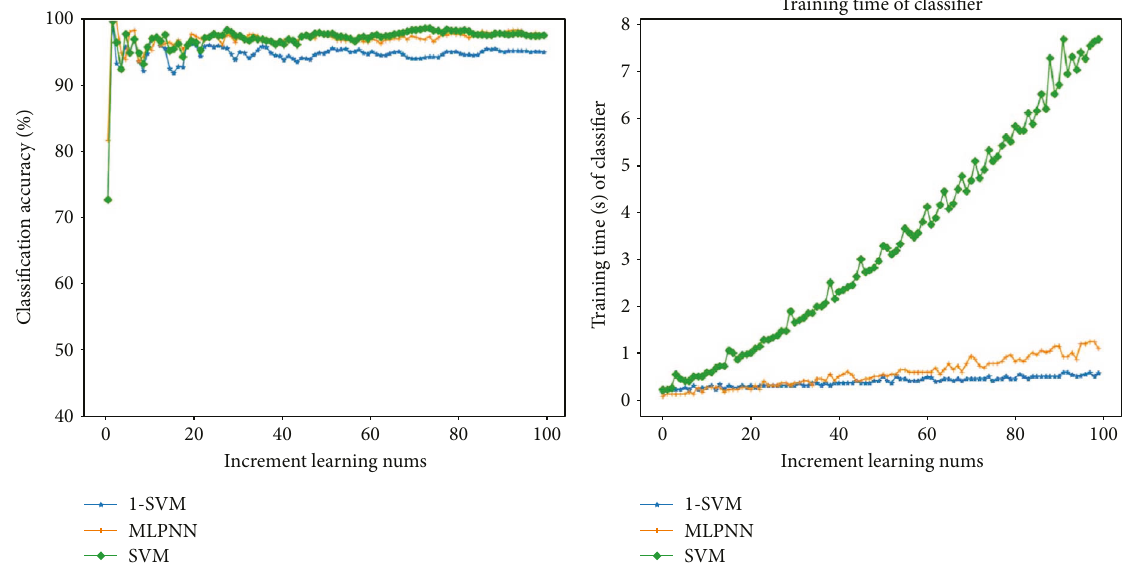
Figure 4: Comparison the classi fi cation accuracy and training time of SVM, I-SVM, and MLPNN